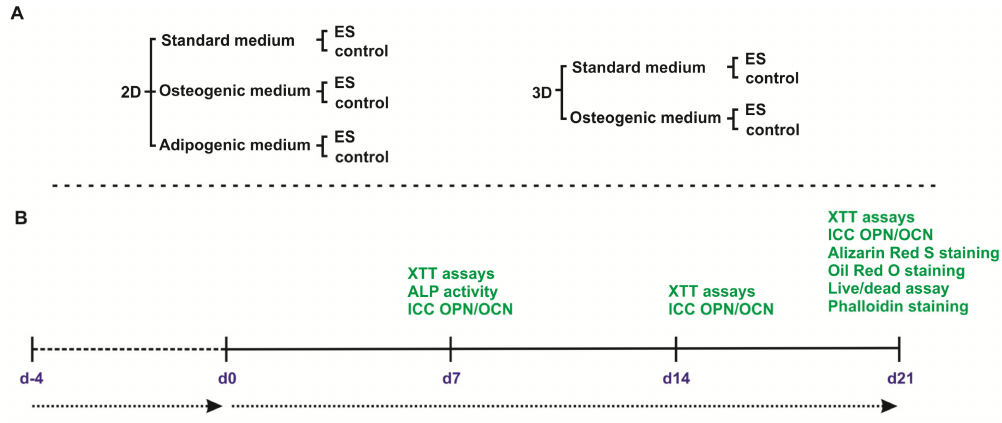
Figure 1. Schematic representation of the experimental design. ( A ) Experimental groups. In 2D, adipose-derived stem cells were di ff erentiated into osteogenic or adipogenic fate or maintained under standard conditions with and without electrical stimulation (ES). In 3D, cells were di ff erentiated into osteogenic fate or kept in standard medium with and without exposure to ES. ( B ) After 4 days of pre-cultivation, medium was replaced by osteogenic, adipogenic, or fresh standard medium. XTT assays and immunocytochemical (ICC) staining against osteopontin (OPN) and osteocalcin (OCN) were performed at day d7, d14, and d21. Alkaline phosphatase (ALP) activity was assessed at d7, whereas Alizarin Red S staining, Oil Red O staining, live / dead assay and phalloidin staining were performed at